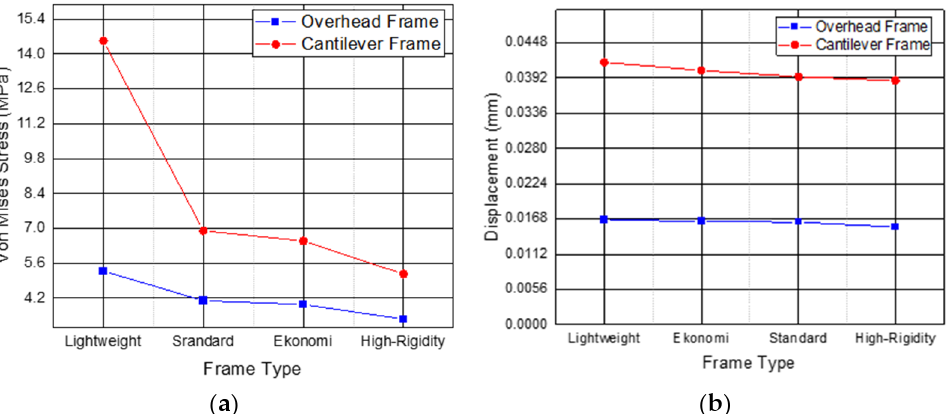
Figure 7. Trend Line Result Comparison on Each Frame Type: ( a ) Von Mises Stress; ( b ) Displacement.